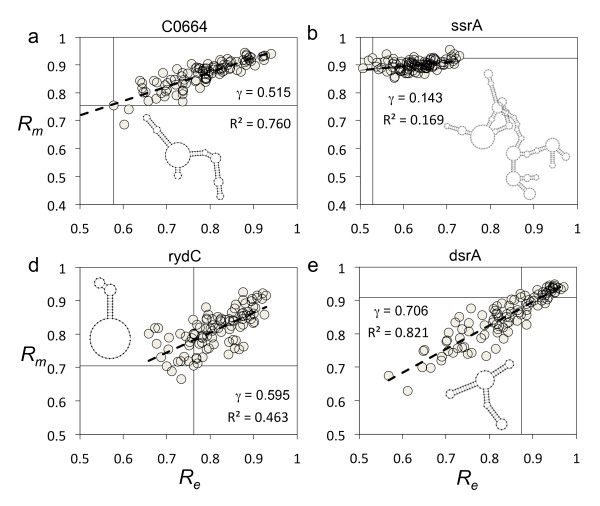
Correlation between mutational and environmental robustness. Computation of mutational and environmental robustness (Rm and Re) for different sncRNAs and their corresponding structural analogs. The robustness of artificial sequences sharing the natural structure was evaluated (γ gives the value of the slope). Solid lines indicate the values for the natural sequence.